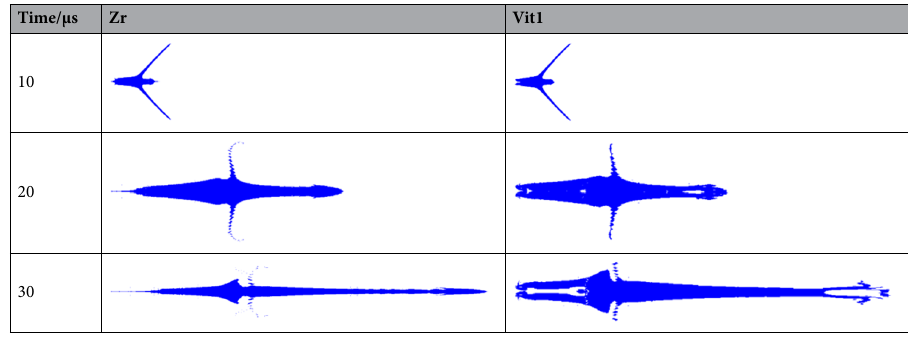
Table 5. Comparison of jet shape between Zr and Vit1.